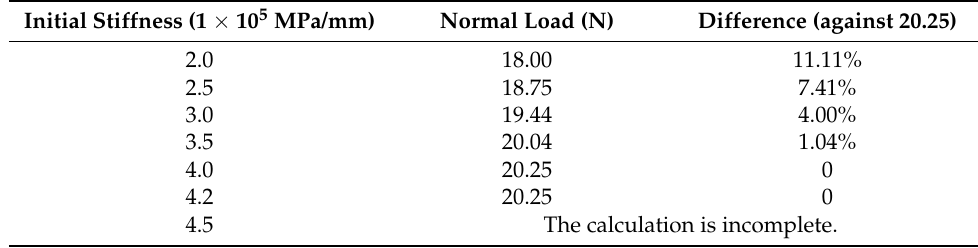
Table 3. Influence of initial stiffness on the delamination